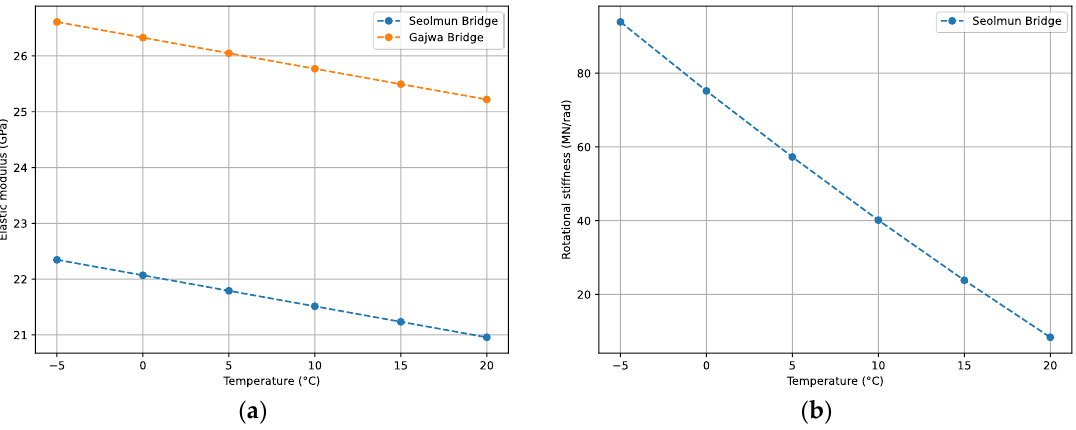
Figure 12. Parameters of updated models: ( a ) elastic modulus of concrete; ( b ) rotational rigidity of bearing.